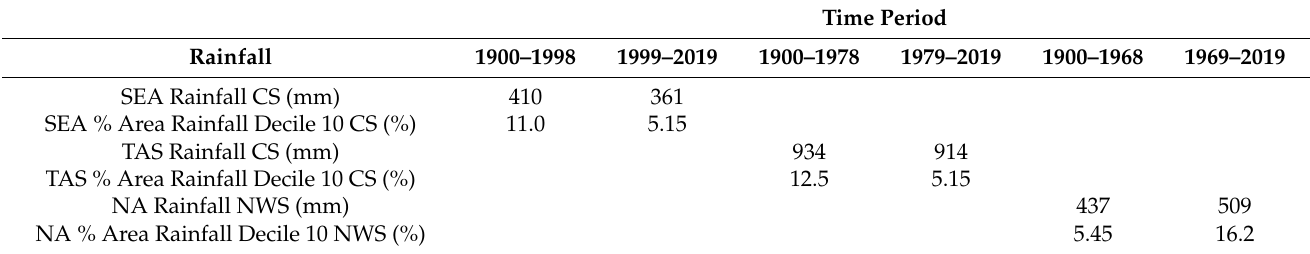
Table 7. As in Table 1 for SEA and TAS Cool Season (CS) rainfall and PAR D10 and NA Northern Wet Season (NWS) rainfall and PAR D10